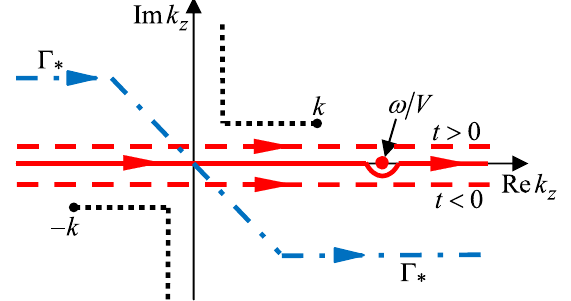
FIG. 2. The complex plane of k z : the cuts (dotted line), the initial integration path (solid line), the transformed integration paths in (21) (dashed lines), and the path Γ (dash-dotted